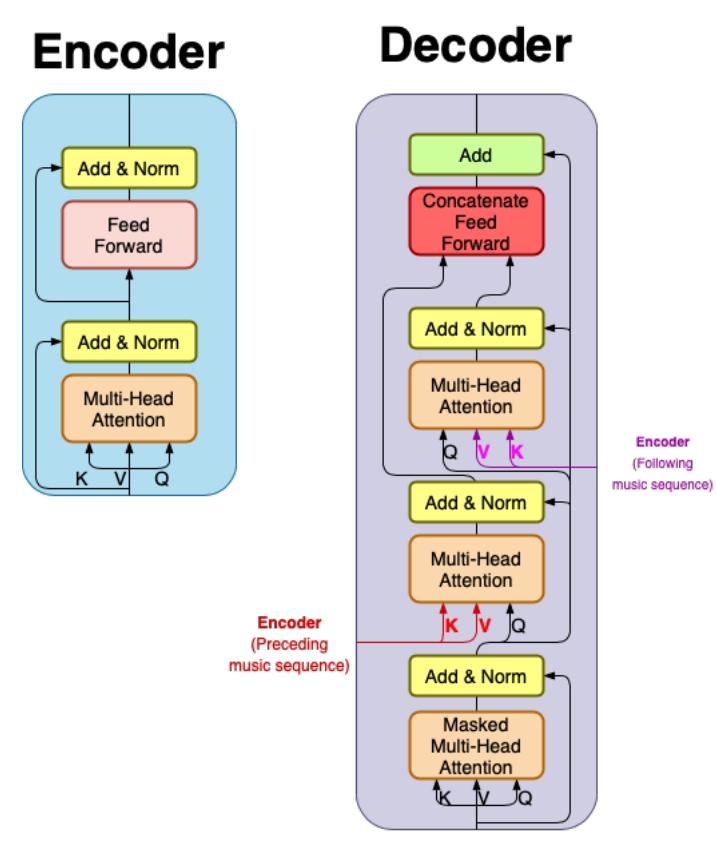
Figure 11. Encoder and